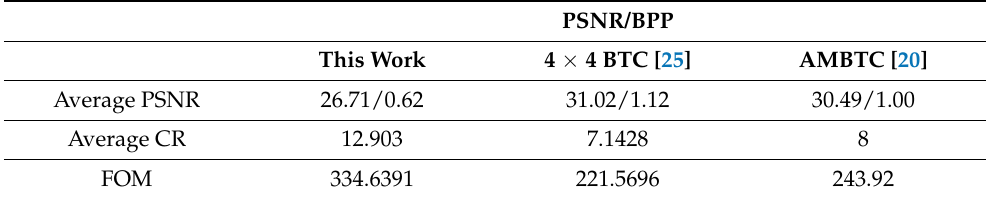
Table 6. Results with other BTC algorithms and this work.